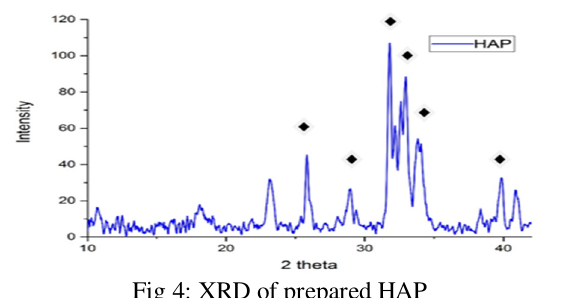
Fig 4: XRD of prepared HAP